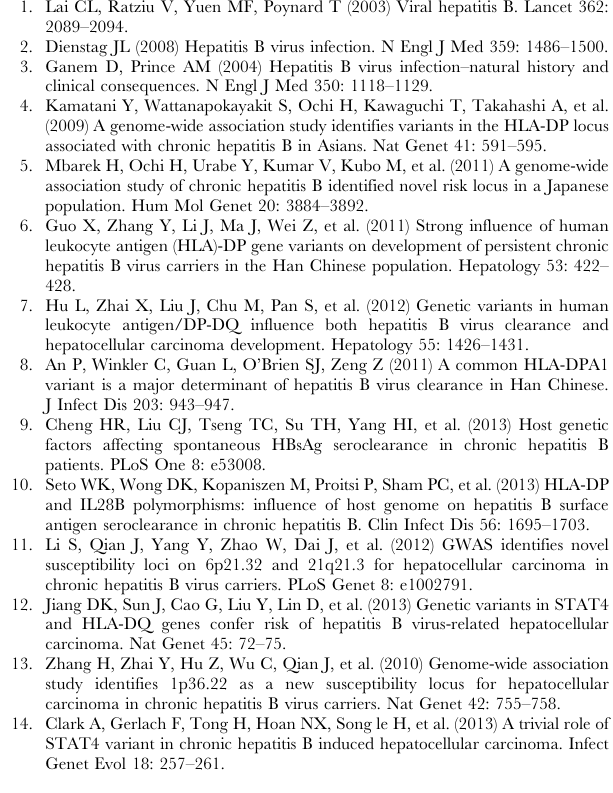
Figure S1 Forest plot for association of STAT4 rs7574865 with HCC development. Figure S2 Publication bias of the four polymorphisms